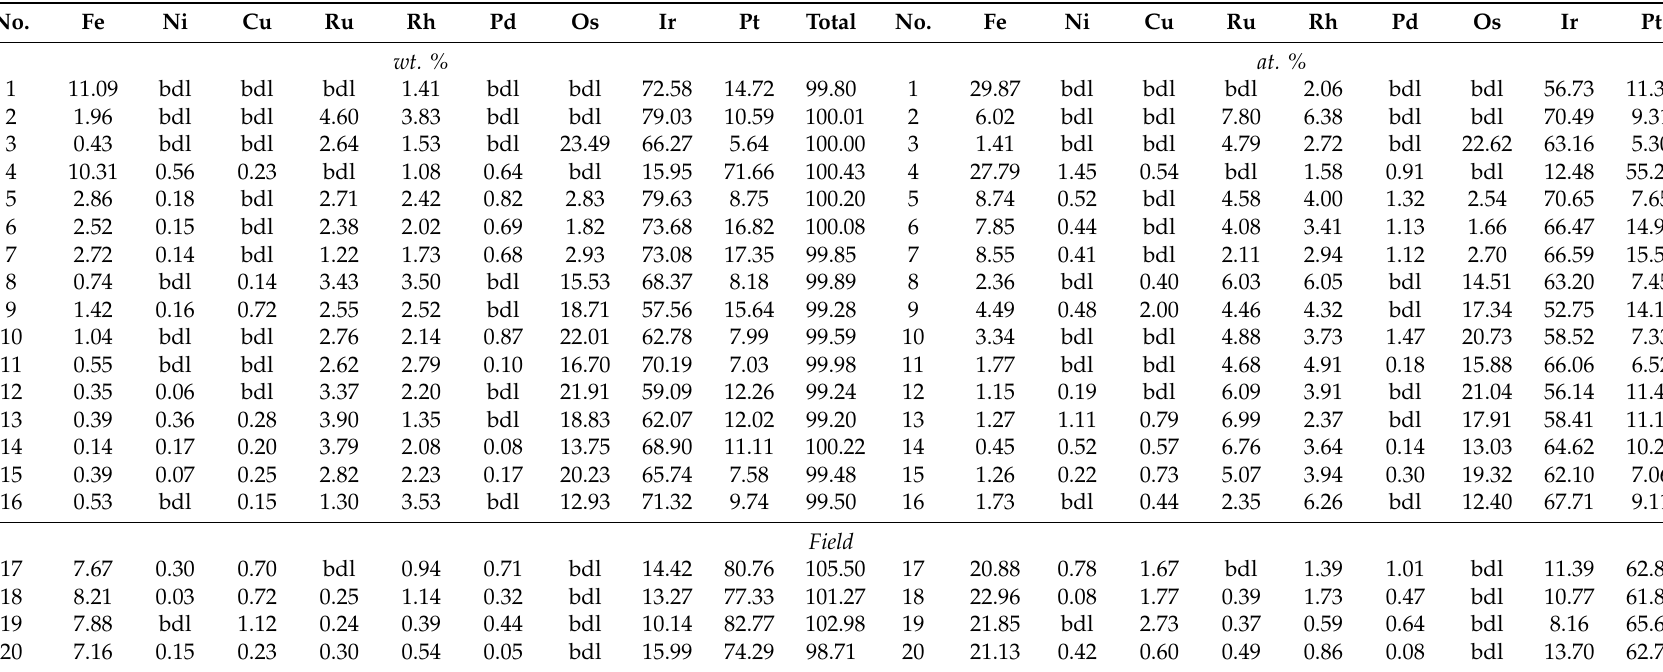
Table 4. Composition of Os-rich iridium from the chromite-platinum ore zones of Svetloborsky massif and associated